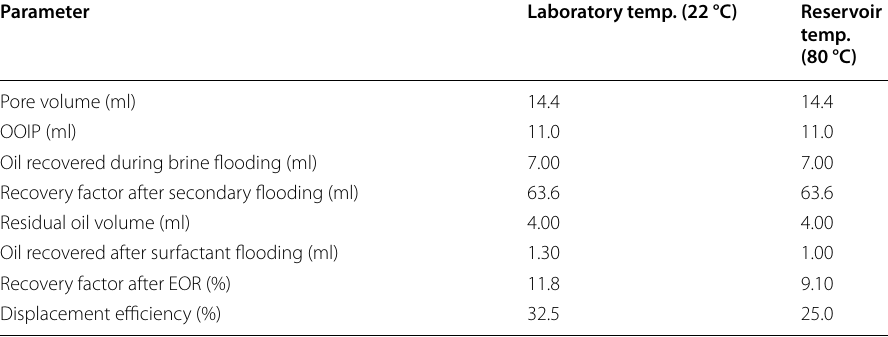
Table 7 Recovery factor after surfactant flooding at laboratory and reservoir temperature